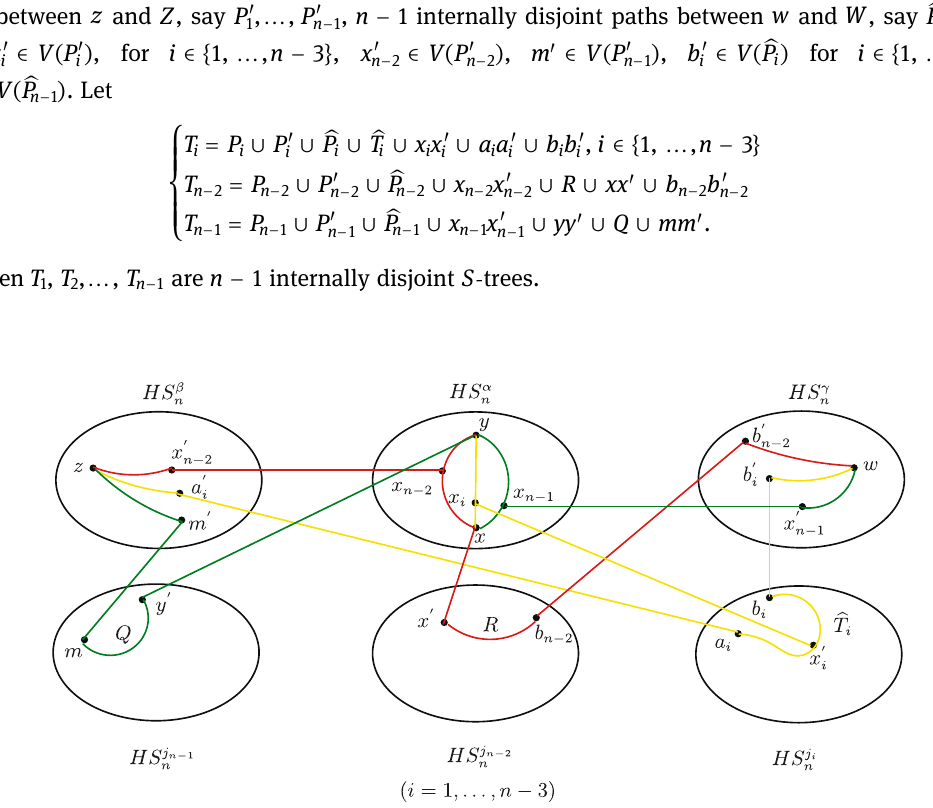
Figure 10: The illustration